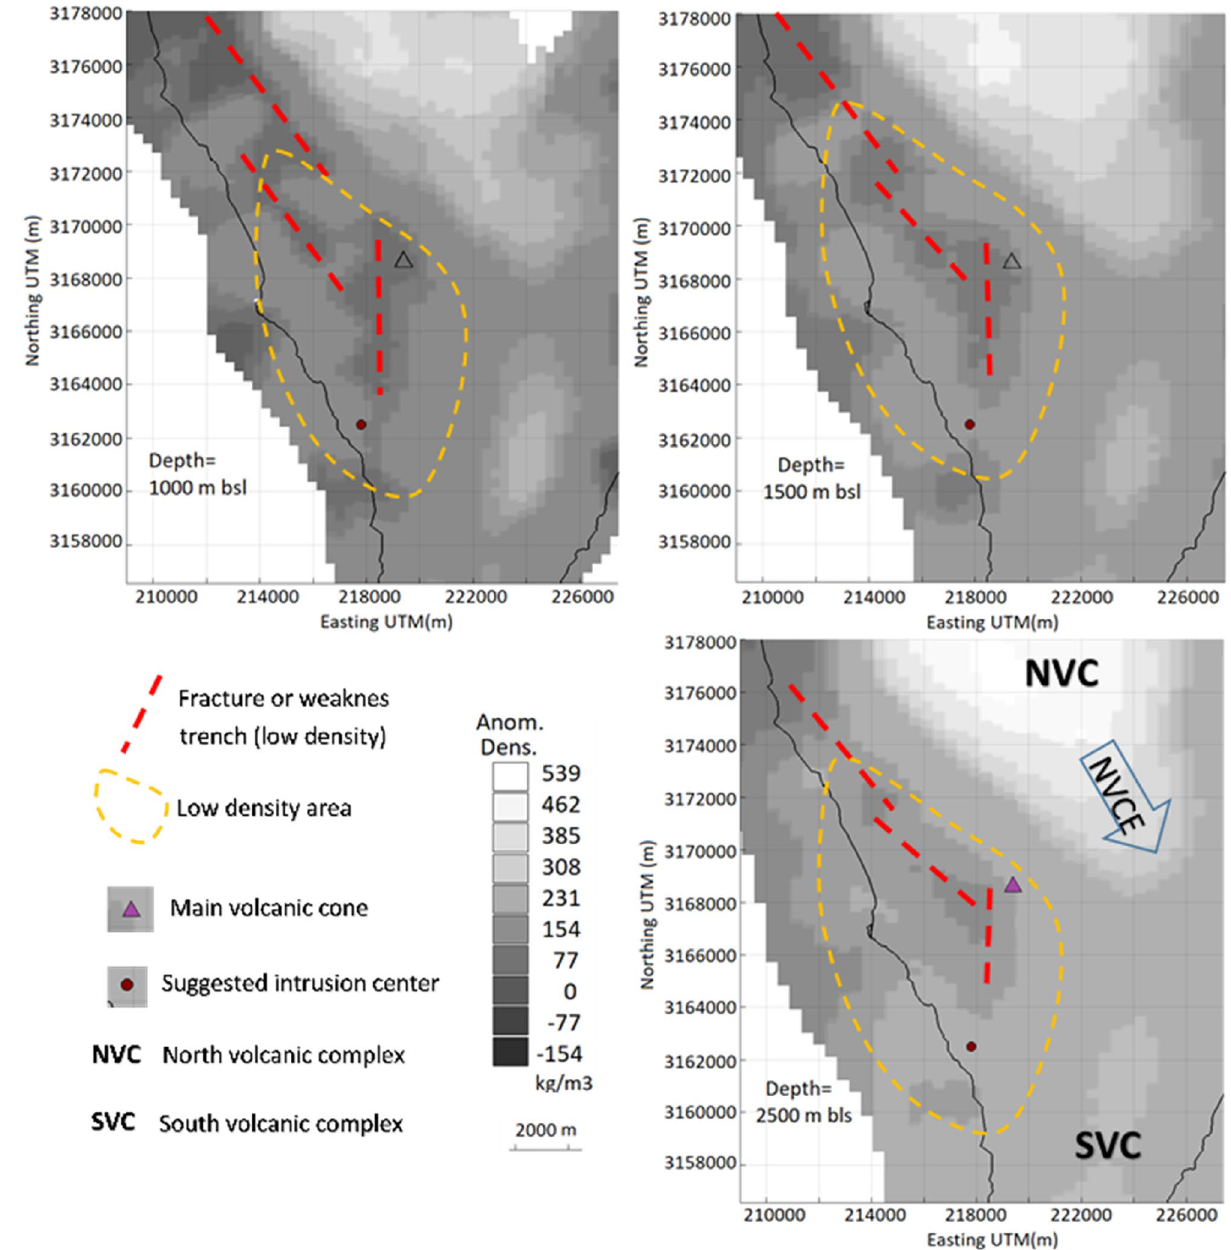
Figure 4. Density crustal model for La Palma Island. Horizontal sections of the crustal density model for La Palma Island at different depths bsl. Density minima alignments, in particular associated with the shallow magma storage and the fissure eruption, are marked with red dashed lines. Triangle indicates the location of the main volcanic vent during the eruption. Red point indicates the location of the deep magma feeding the shallow magmatic reservoir below Jedey area from our geodetic modeling. Low density area is approximately delineated by the dashed yellow line. Matlab software (www. mathw orks. com) and Microsoft PowerPoint 2016 were used to create this